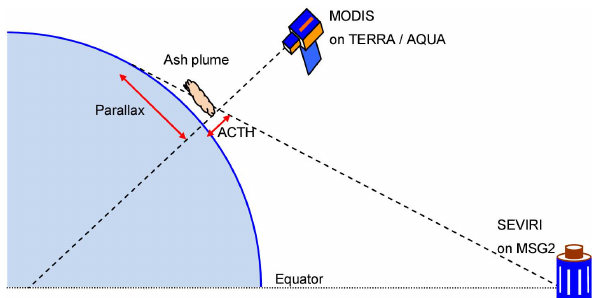
Fig. 1. If an ash cloud is observed simultaneously from two satel- lites the position of the cloud seems to be shifted for a parallax when comparing both datasets. The parallax is a consequence of viewing geometries of both satellites and the height of the ash